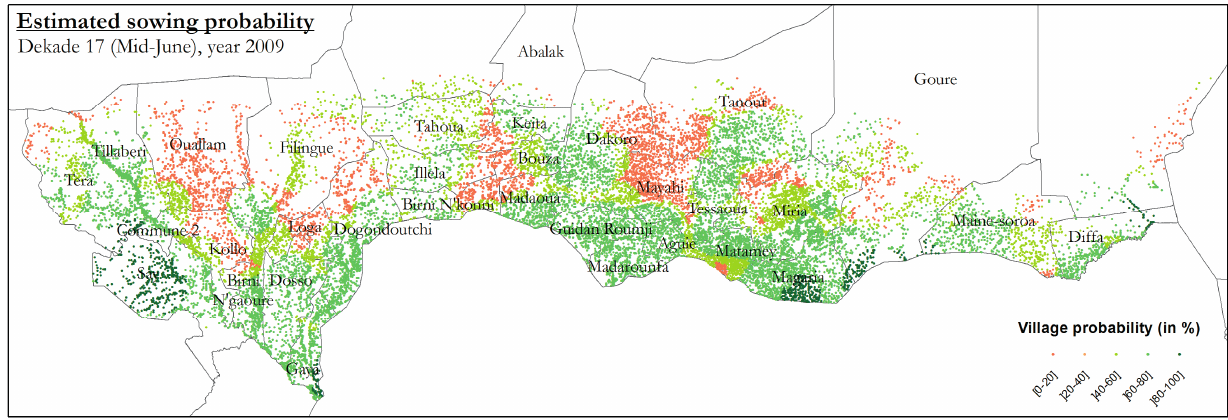
Figure 6. Estimated sowing probabilities at the village level for the 17th dekad of 2009 from the 2009 model with Lag0 and 20 pixels